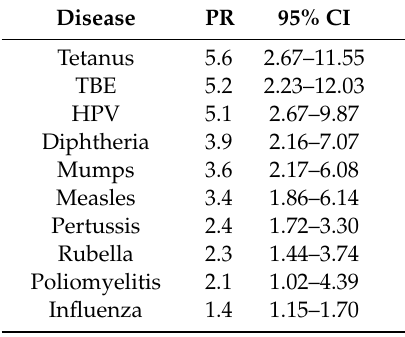
Table 5. Association (prevalence ratio (PR) and 95% confidence interval (95% CI)) between having been classified as hesitant and intention to vaccinate.